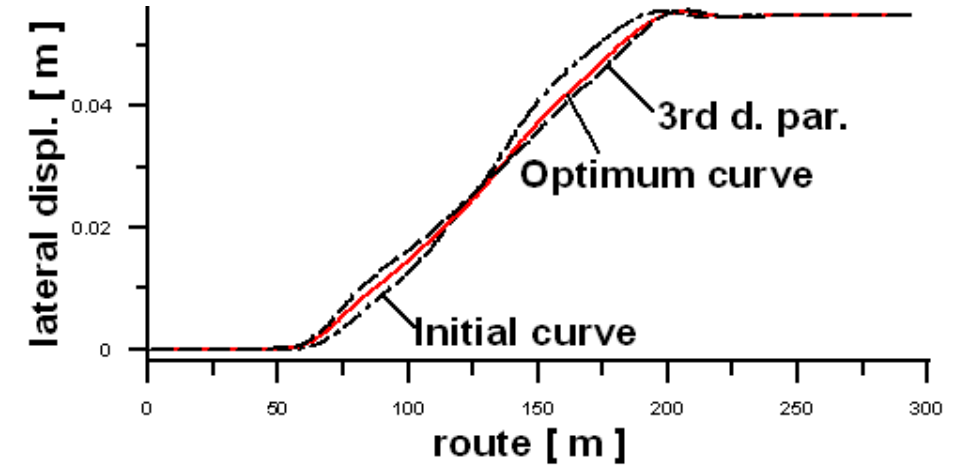
Figure 9. Lateral displacements for 9th degree (soft suspension, v = 24.26 m/s 2 ).